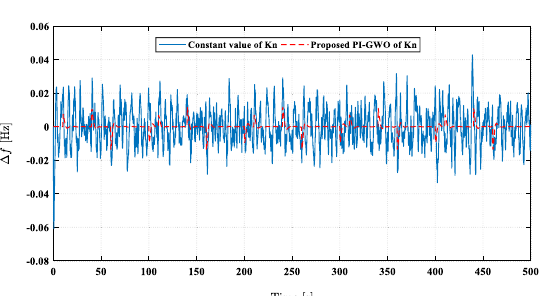
Fig. 15 The frequency deviation of Case